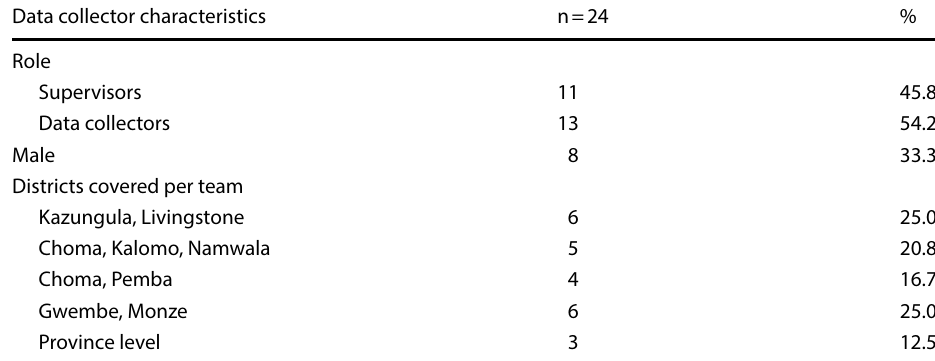
Table 1 Characteristics of data collectors who participated in in-depth interviews and focus group